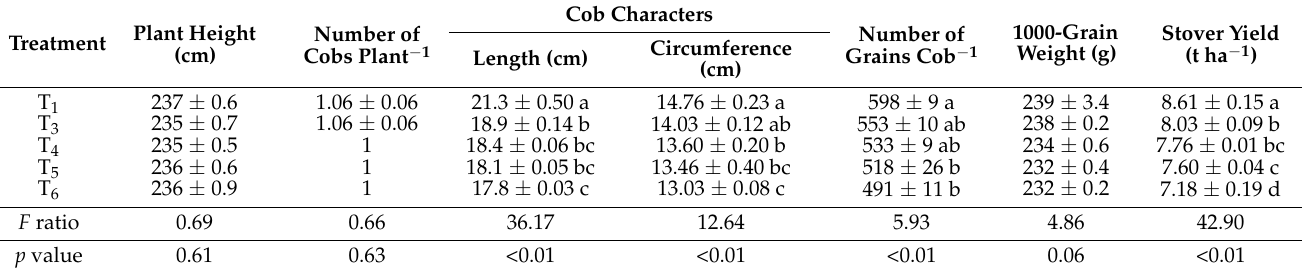
Table 2. Yield and yield contributing characters of maize grown under different treatments (means ± SE, N = 3).